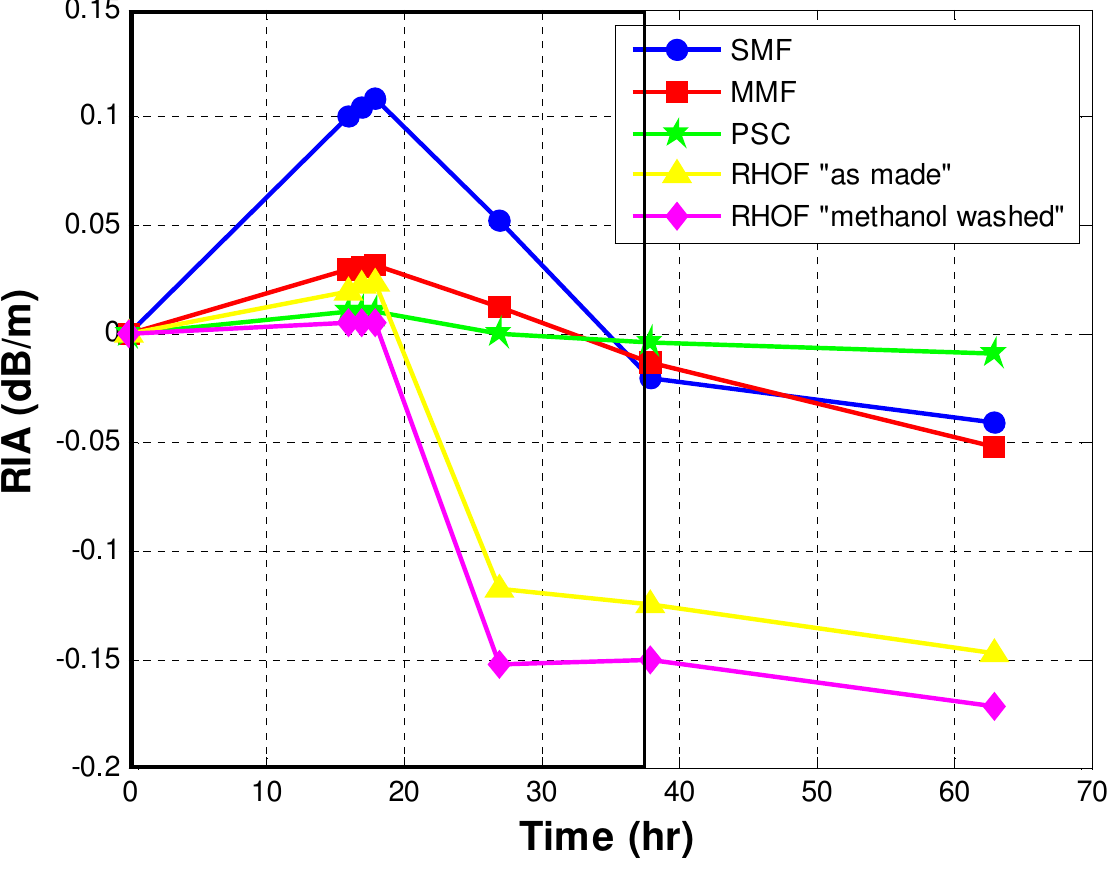
Figure 7. RIA of sample fibers for the total duration of the experiment showing the fibers behavior under and post